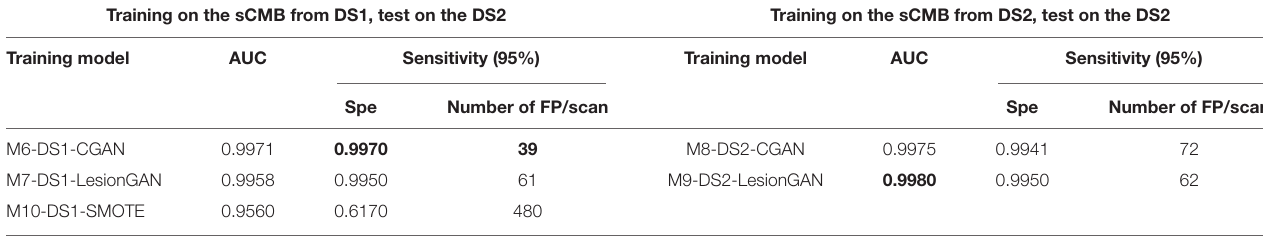
TABLE 6 | Results of cerebral microbleed (CMB) classification on the whole MRI image. Training on the sCMB from DS1, test on the DS2 Training on the sCMB from DS2, test on the DS2 Training